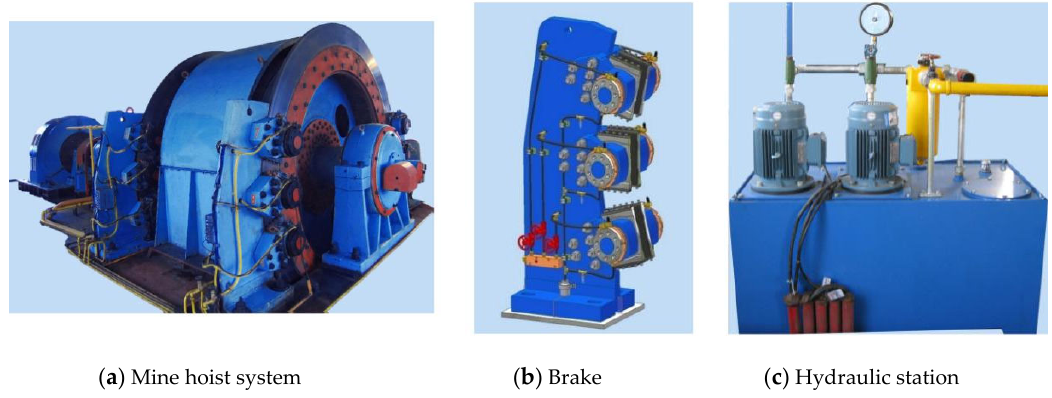
Figure 1. Structure of mine hoist brake system.